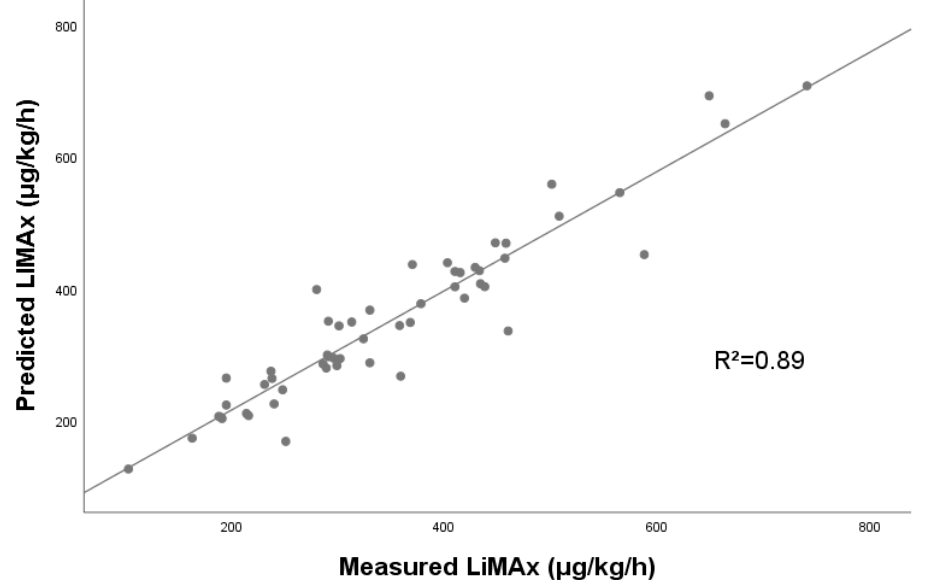
Figure 3. Regression analysis of predicted LiMAx vs. measured LiMAx.